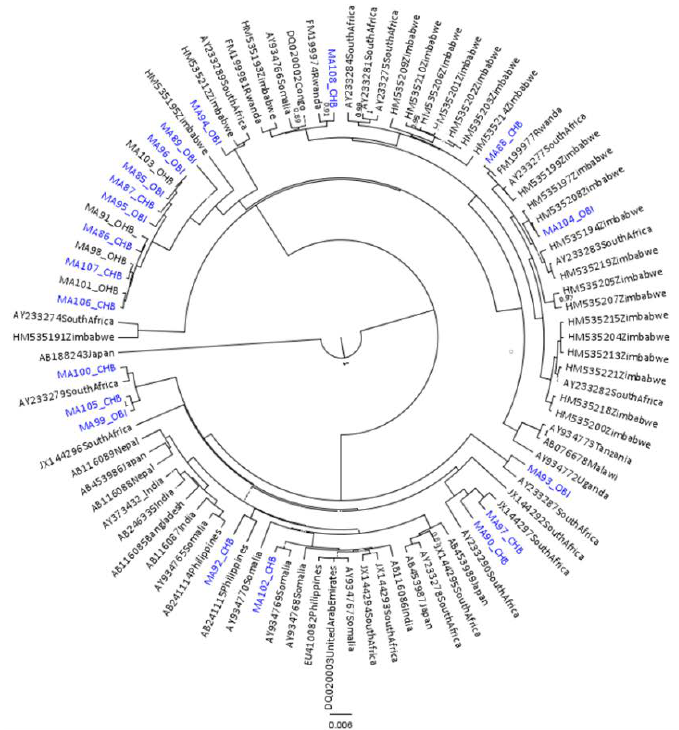
Figure 1. A phylogenetic tree of the whole surface region (nucleotide (nt) 2854–835 from EcoRI site) of subgenotype A1 hepatitis B virus (HBV) sequences generated by Bayesian Evolutionary Analysis by Sampling Trees (BEAST). Strains from Botswana sequenced in the present study are shown in blue, while reference sequences are shown in black. Reference strains are designated by their accession number and country of origin, whereas Botswana sequences are designated by MA followed by a number and either CHB (for chronic HBV strains) or OBI (for occult HBV strains).